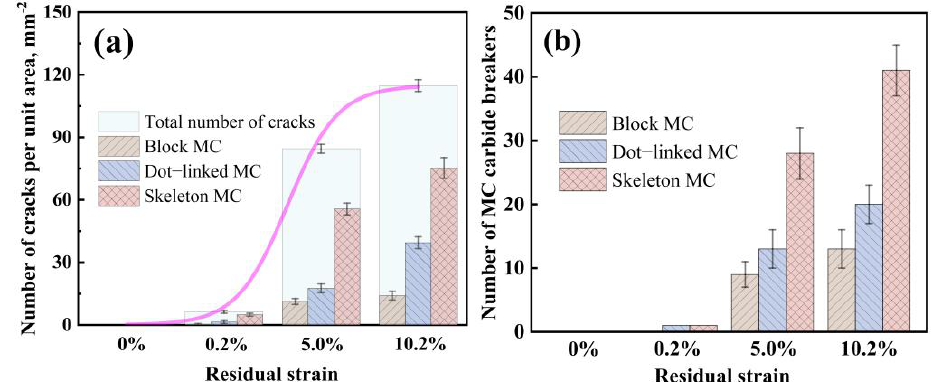
Figure 6. Statistical results at various residual strains. ( a ) The increase in cracks per unit area number is closely related to strain. ( b ) The increasing tendency of skeleton-type MC carbides is significantly higher than the other two types of MC carbides.